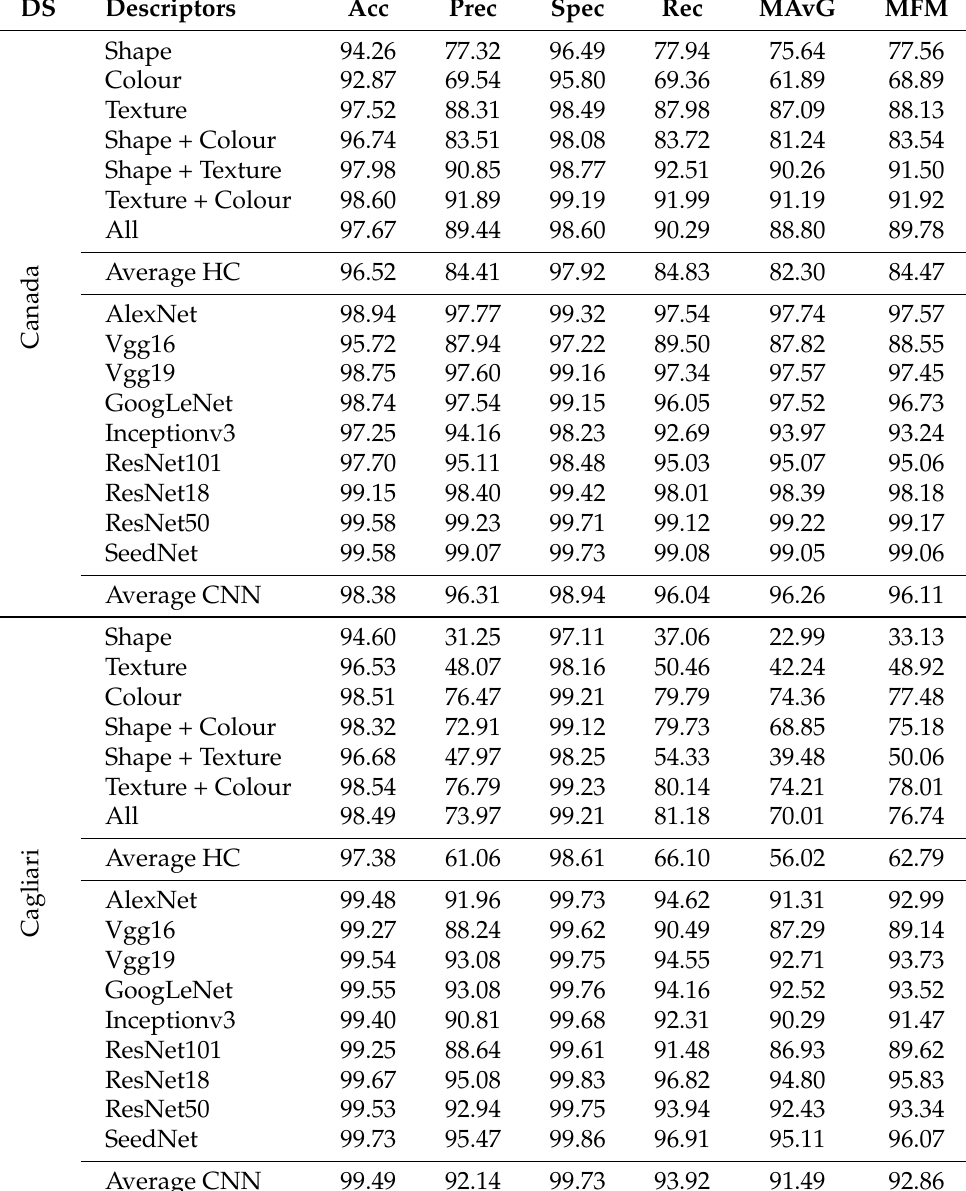
Table A4. Performance results attained using HC descriptors and deep features by SVM classifier on Canada and Cagliari data sets. SVM was trained with a polynomial kernel of order 2. DS indicates the data